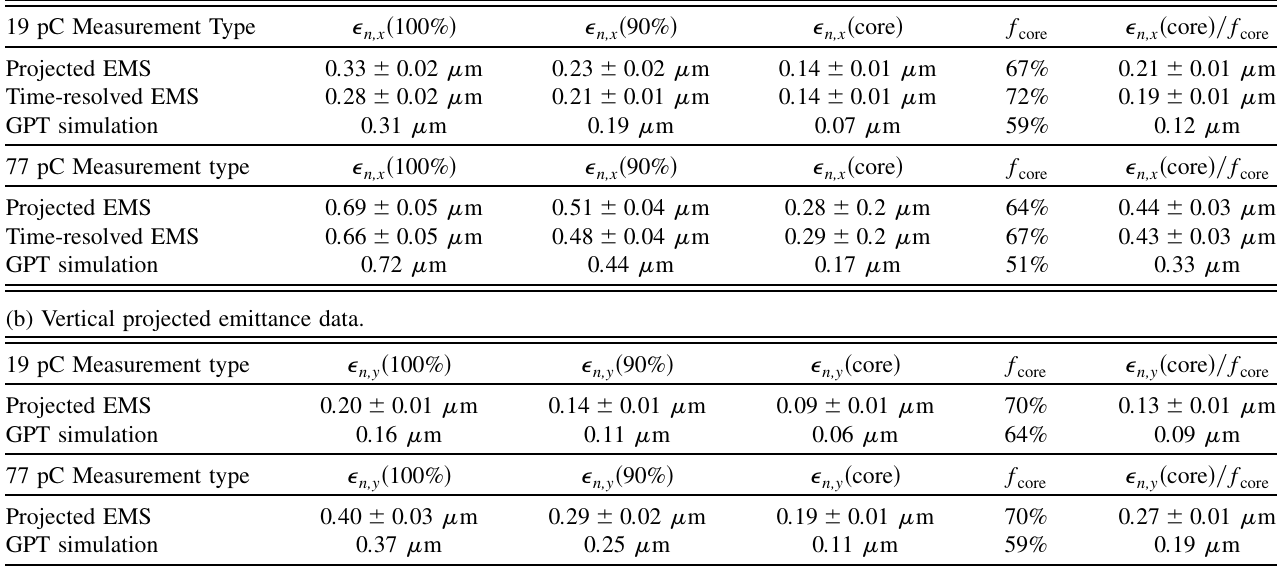
TABLE III. Measured and simulated projected horizontal (a), and vertical (b) emittances. (a) Horizontal projected emittance